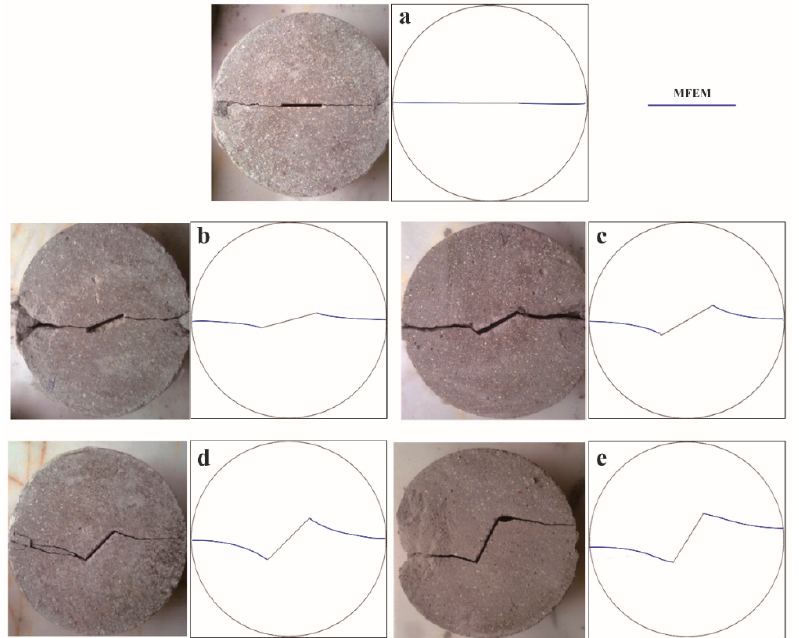
Figure 8. Comparison of simulation results and experimental results for crack paths in CCBD specimens for α = 0.3. ( a ) β = 0 ◦ , ( b ) 15 ◦ , ( c ) 30 ◦ , ( d ) 45 ◦ , ( e ) 60 ◦ .